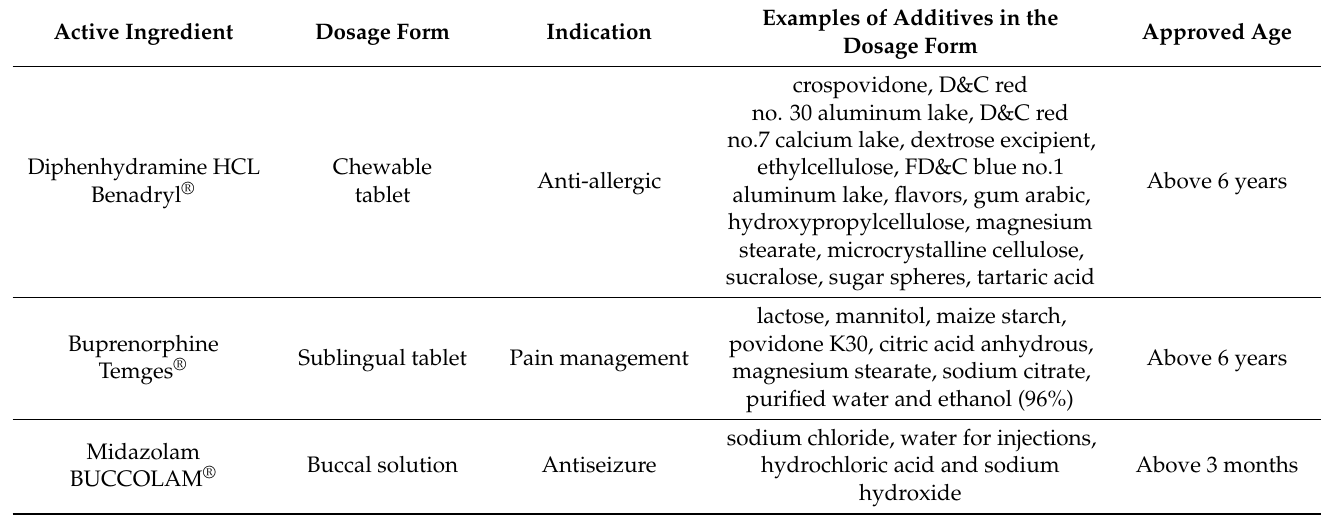
Table 2. Examples of oral transmucosal buccal formulations and their